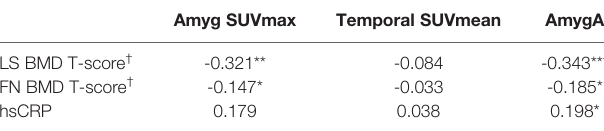
TABLE 2 | Correlation